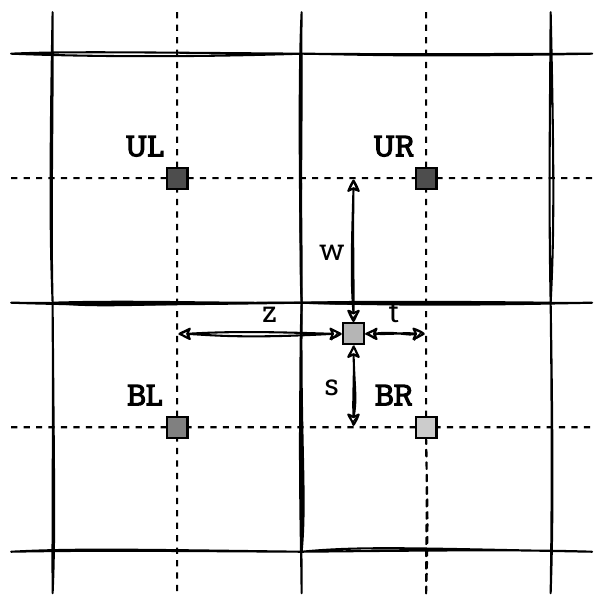
Figure 7. Bilinear interpolation